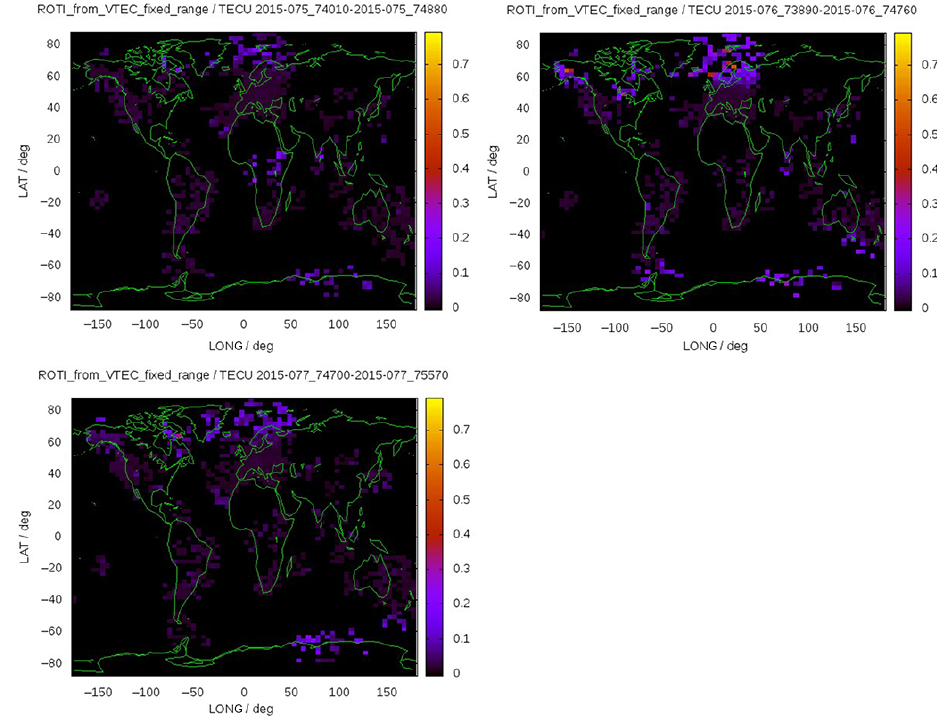
Figure 12. The global ROTI maps for the St. Patrick’s Day storm period (16, 17 and 18 March, around